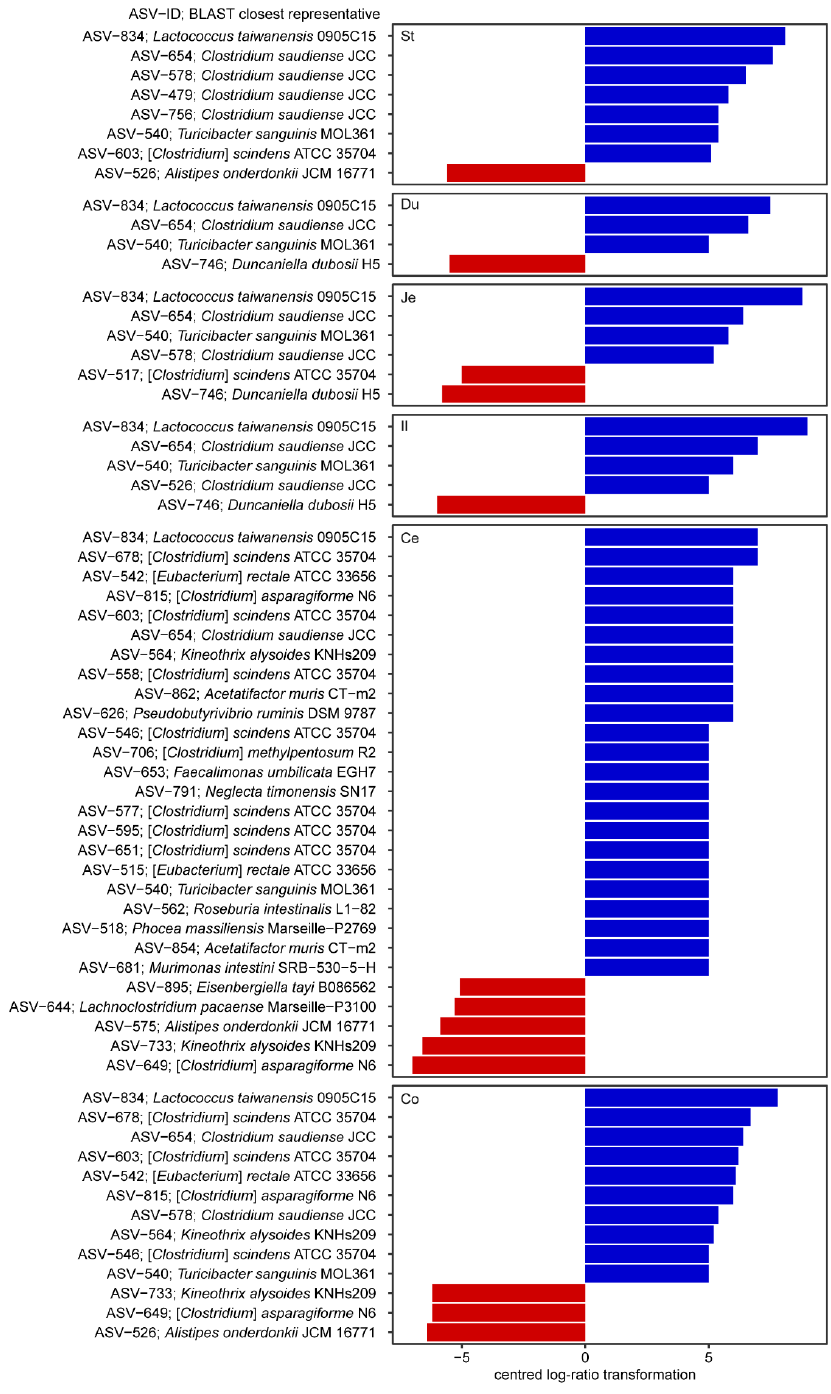
Figure 5. A bar-plot of differentially abundant ASVs within gut segments and fecal microbiota of mice fed a standard or western diet. Standard diet and western diet are shown as red and blue, respectively. Differential abundant ASVs were identified using analysis of the composition of microbiomes (ANCOM) method. Only statistically significant ASVs that fall within a distribution cut-off based on W values are shown (Table S5A for W values).